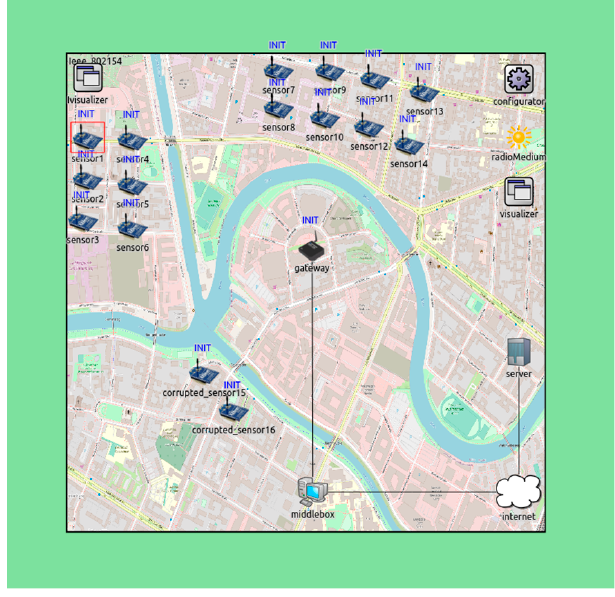
Figure 6. General structure of the use case.